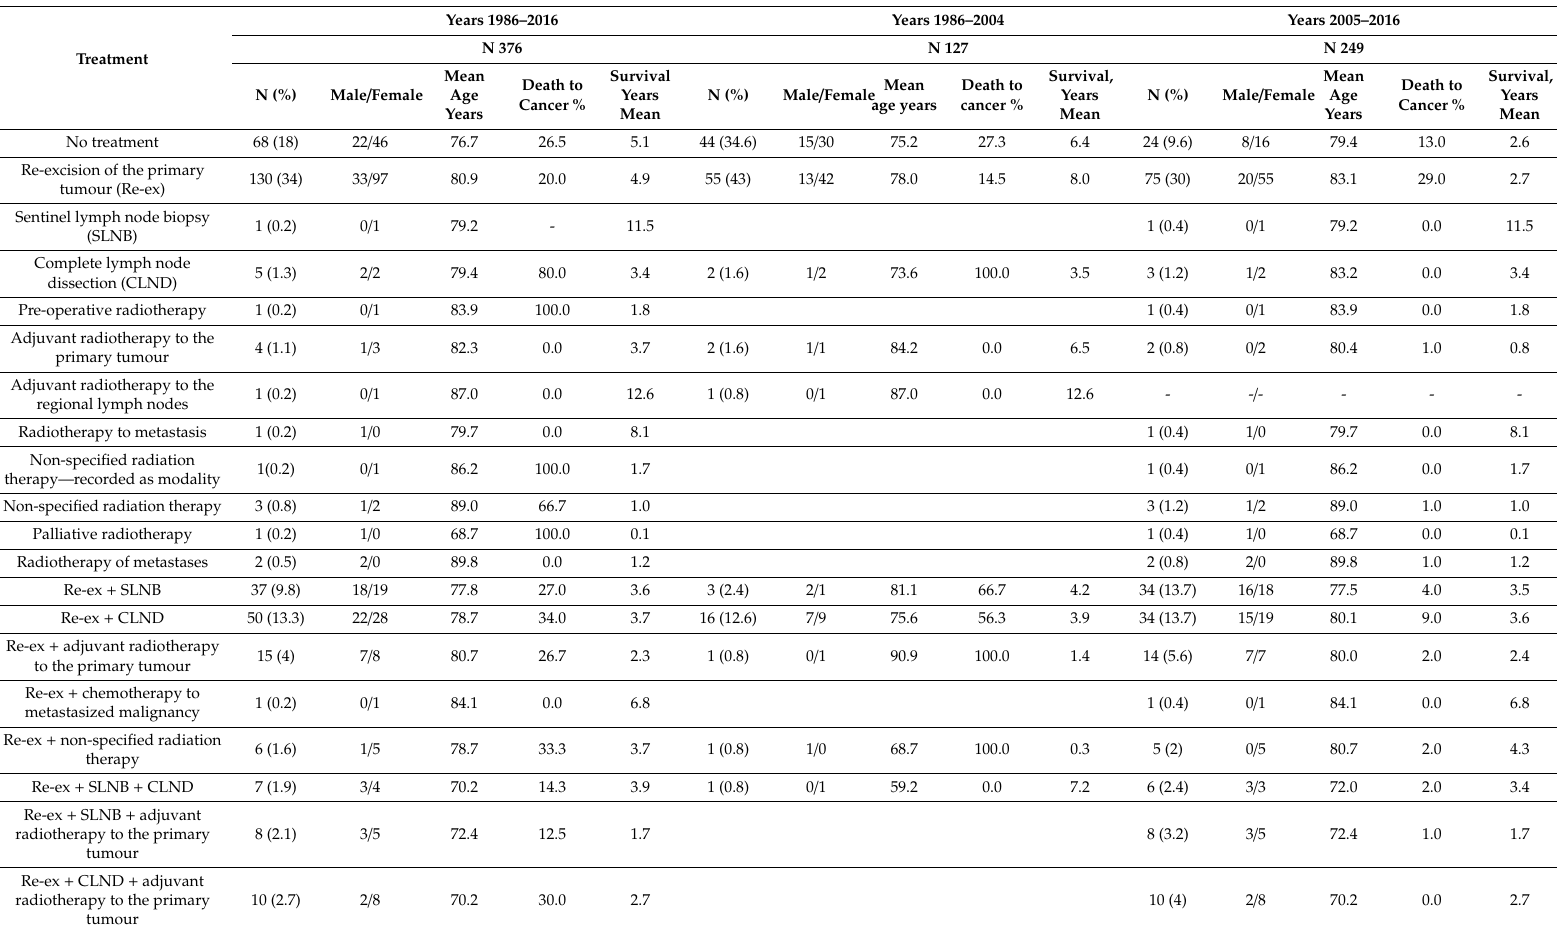
Table 3. Treatments and their combinations with MCC-specific